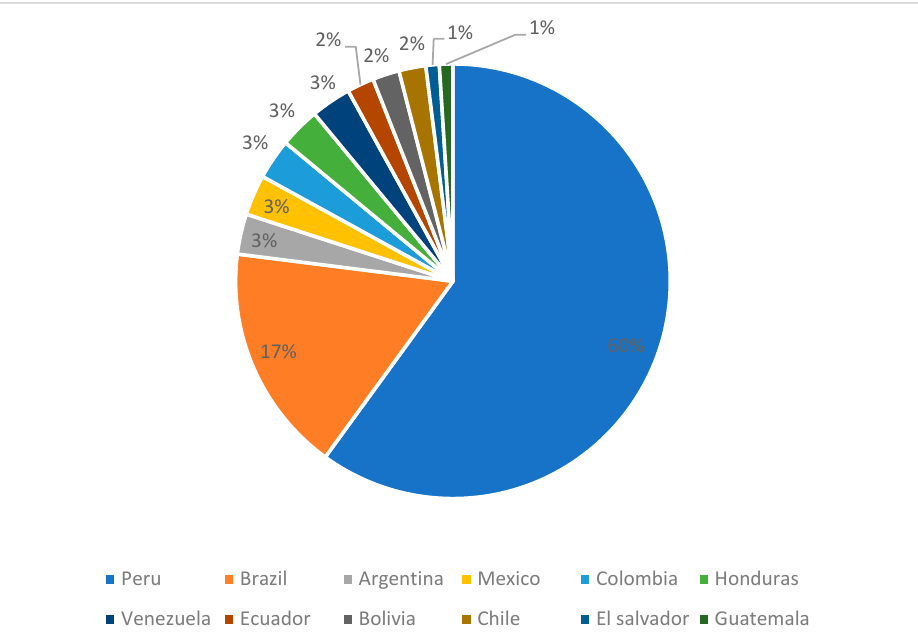
Figure 3. Percentages of deliveries (total N = 1338) by women at risk who gave birth in Careggi University Hospital, according to country of origin.